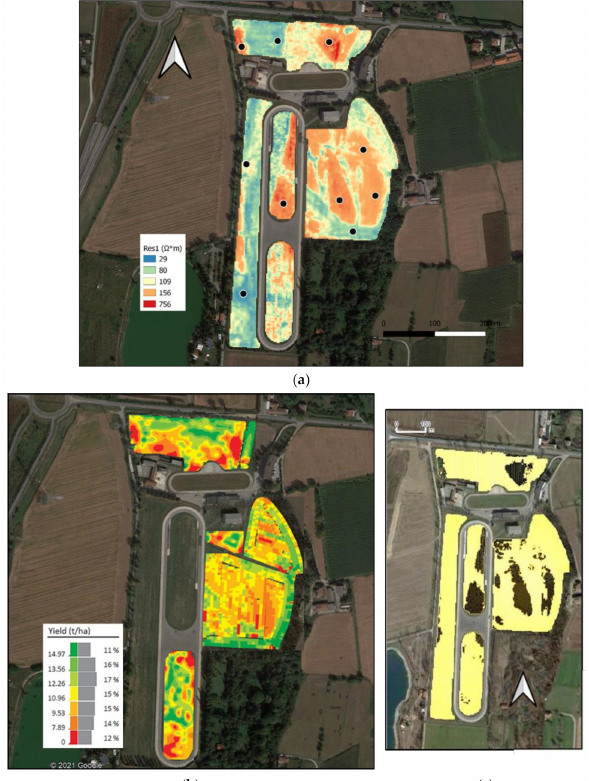
Figure 3. ( a ) Soil resistivity map (0–50 cm layer). Black dots indicate soil profile locations; ( b ) the yield map resulting from the on-the-go sensor output for Triticale (t ha − 1 ) that could be compared to the soil electrical resistivity map; and, ( c ) representation of the two management zones resulting from the analysis of the principal spatial components of soil resistivity and forage yield